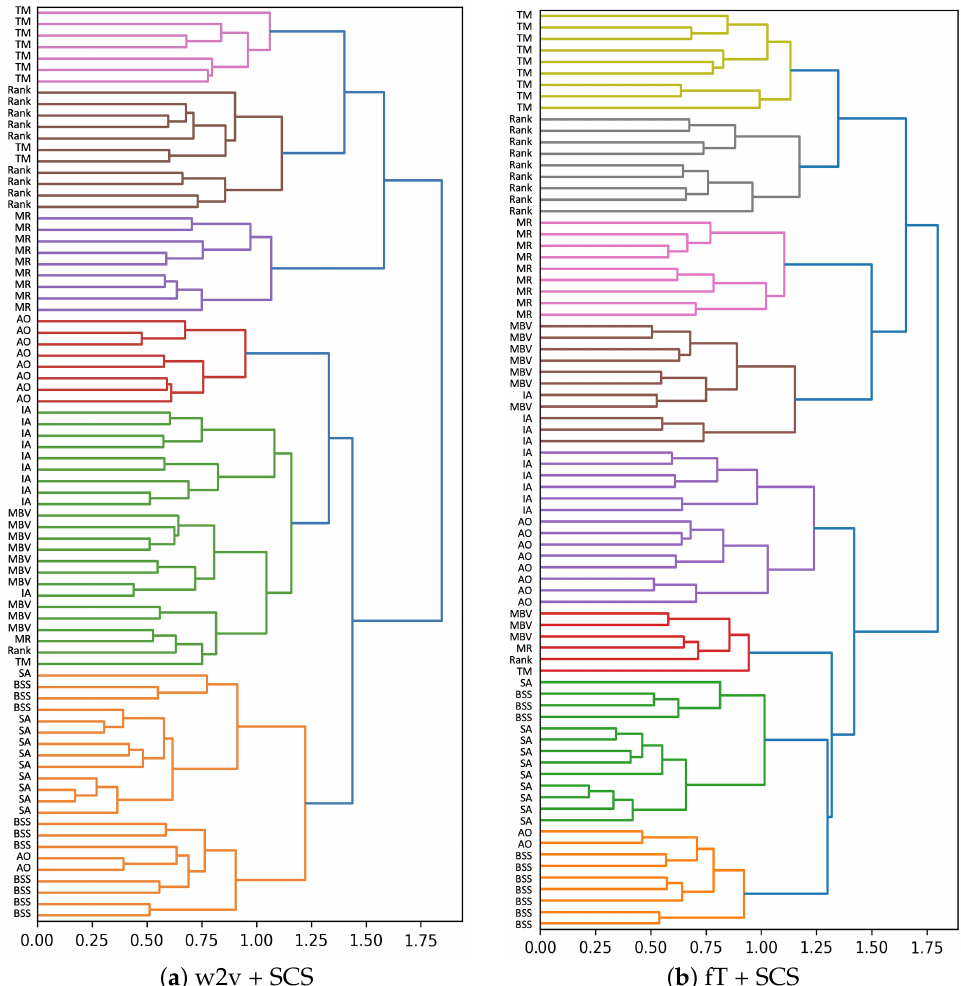
Figure 7. Task II–clustering. Comparing w2v + SCS and fT + SCS shows that their behavior is similar, and that the results are good for some categories (e.g., TM, Rank, and MR.). Colors denote clusters that have been determined automatically by the plotting algorithm, and the threshold can be fine-tuned if